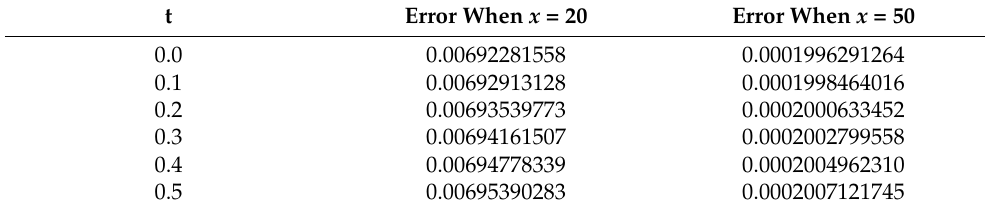
Table 2. Absolute error for Case 2 for x = 20, x = 50.